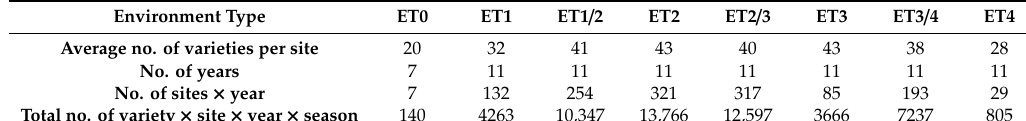
Table 1. General information about National Variety Trials (NVT) dataset. The average number of varieties per site, number of years, total number of sites during consecutive years, and total number of data in individual environment types (ETs).